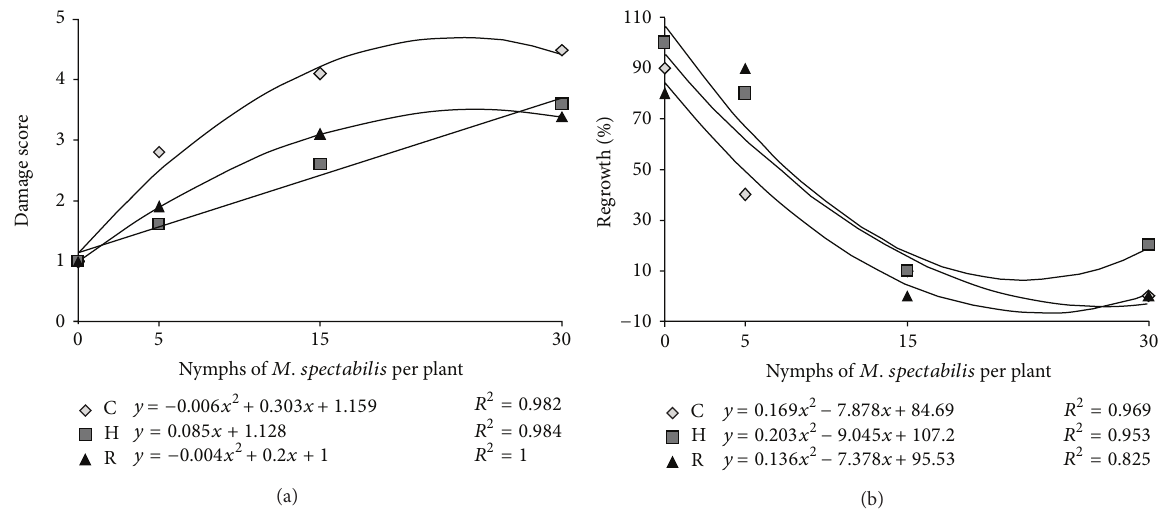
Figure 2: Leaf damage (a) (damage score) and regrowth (%) (b) of Brachiaria ruziziensis cultivated under recommended (R), half of recommended (H), and control (C) fertilization and exposed to different Mahanarva spectabilis nymphs densities.